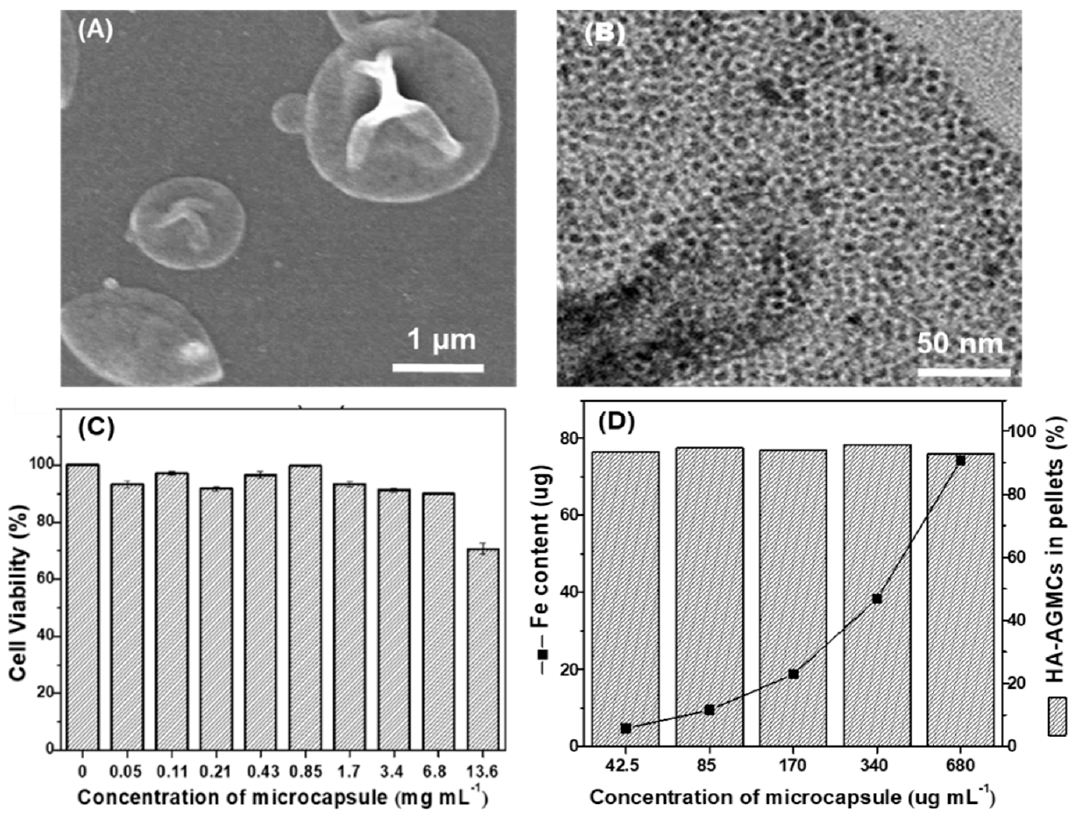
Figure 3. Morphological appearance and characterization of the HA-AGMCs. ( A ) SEM and ( B ) TEM images. ( C ) Biocompatibility of HA-AGMCs to chondrocytes after 24 h incubation (n = 3). ( D ) Attachment efficiency of HA-AGMCs to chondrocytes in different concentrations of HA-AGMC. The results demonstrated HA-AGMCs have a spherical-shaped bilayers structure with average diameter of 1.2 μ m and negligible cytotoxicity to chondrocytes.